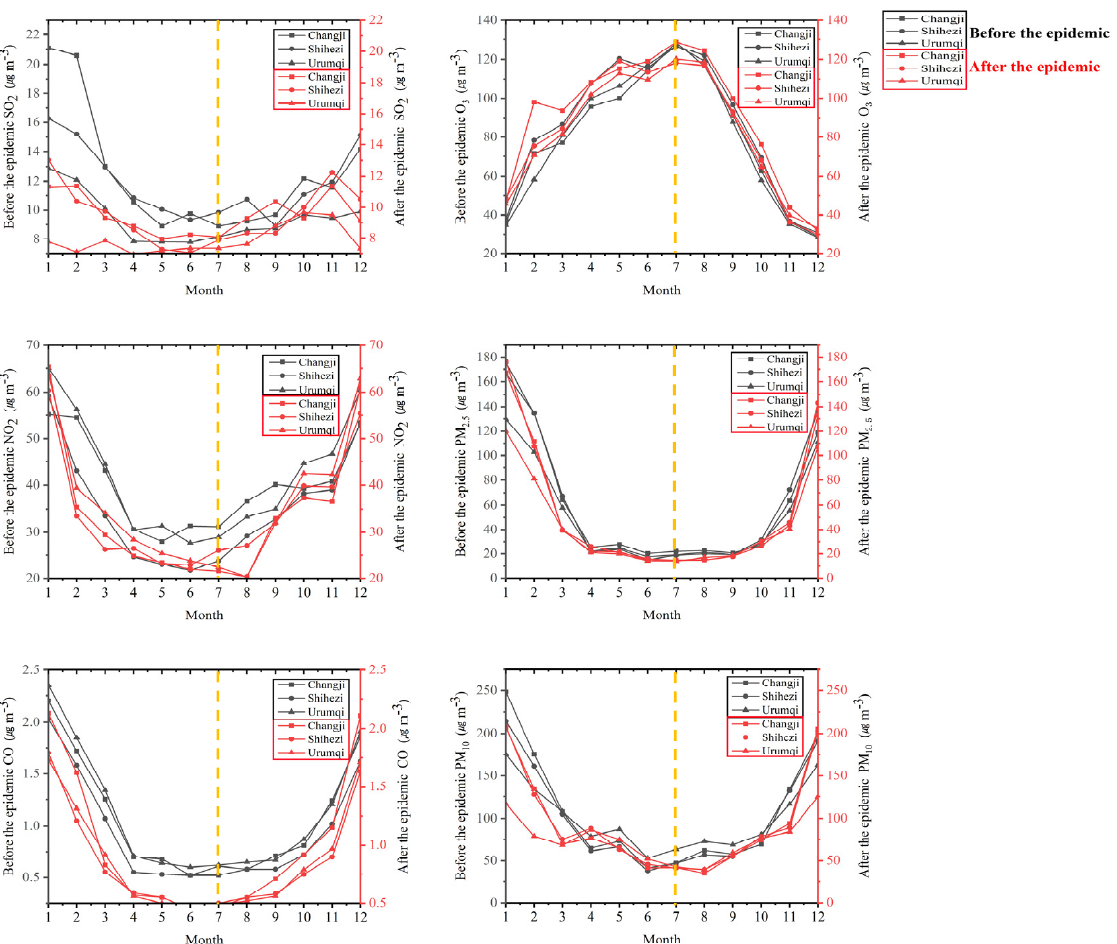
Figure 9. Average air pollutants concentrations in the Wu-Chang-Shi urban before and after the COVID-19 outbreak. ( μ g m − 3 ).